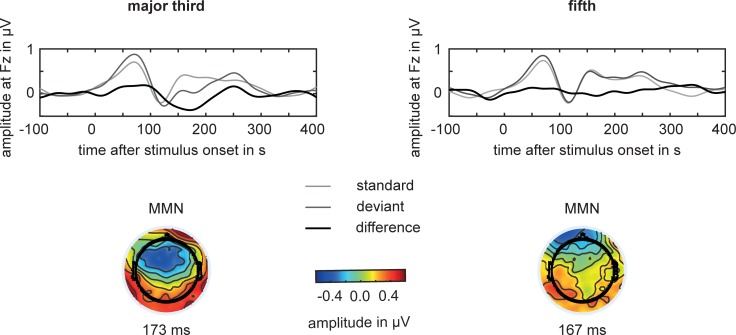
Grand average ERP waveforms as elicited by ‘standard’ (light gray line) and ‘deviant’ (dark gray line) major third (left) or fifth (right) intervals at Fz. The black lines show the difference waveforms between the ‘deviant’ and ‘standard’ waveforms. The contour maps show the distribution of response polarities on an average scalp at the latency of the MMN. Clear fronto-central negativity is only evoked by the major third deviants.